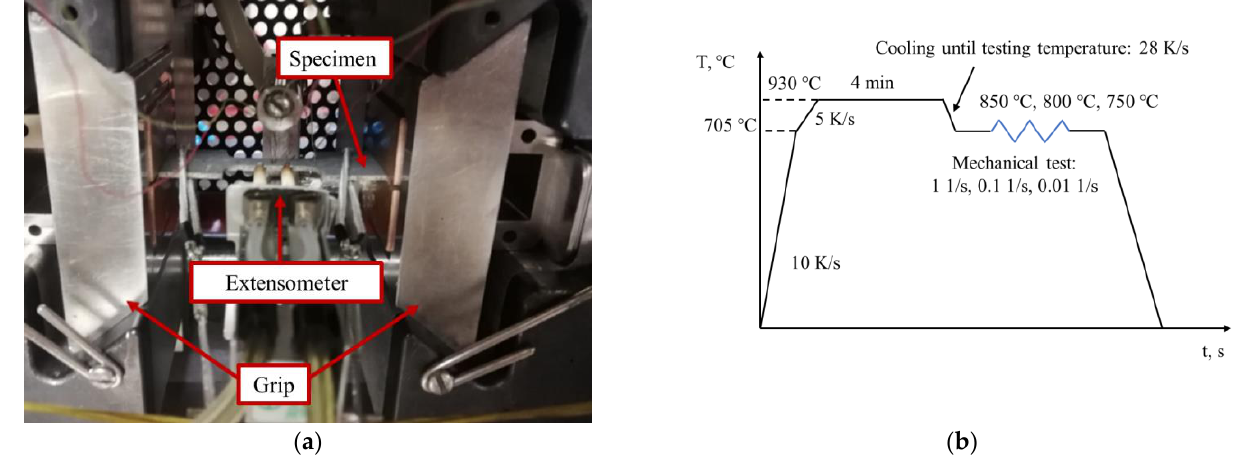
Figure 1. ( a ) Setup for Gleeble tests; ( b ) Scheme of thermo-mechanical cycles imposed on Gleeble